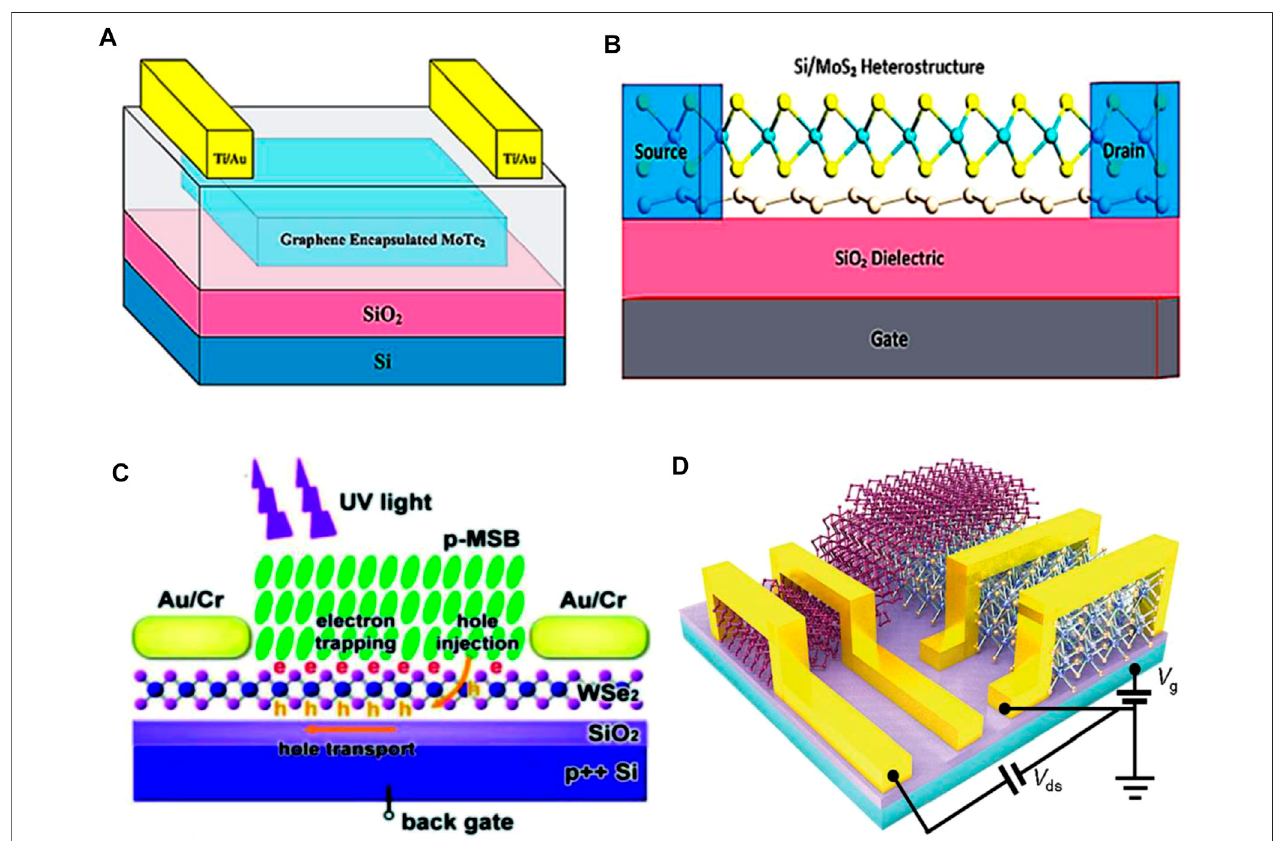
FIGURE 11 | Schematic of (A) MoTe 2 /graphene-based photodetector (Kharadi et al., 2021), (B) Silicene/MoS 2 based photodetectors (Kharadi et al., 2021), (C) (MSB)/WeS 2 based photodetectors (Qiu and Huang, 2021), and (D) BP- WSe 2 photodetector (Zong et al., 2020); Reproduced with permission from (Kharadi et al., 2021; Zong et al., 2020; Qiu and Huang, 2021).